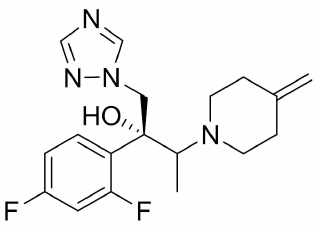
Figure 1. Chemical structure of efinaconazole.